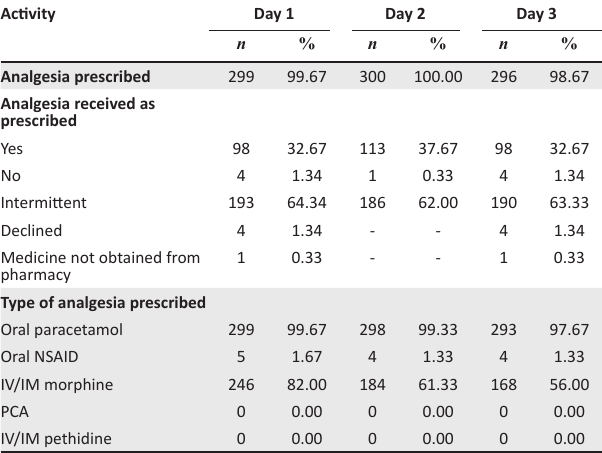
TABLE 4: Prescription and administration of